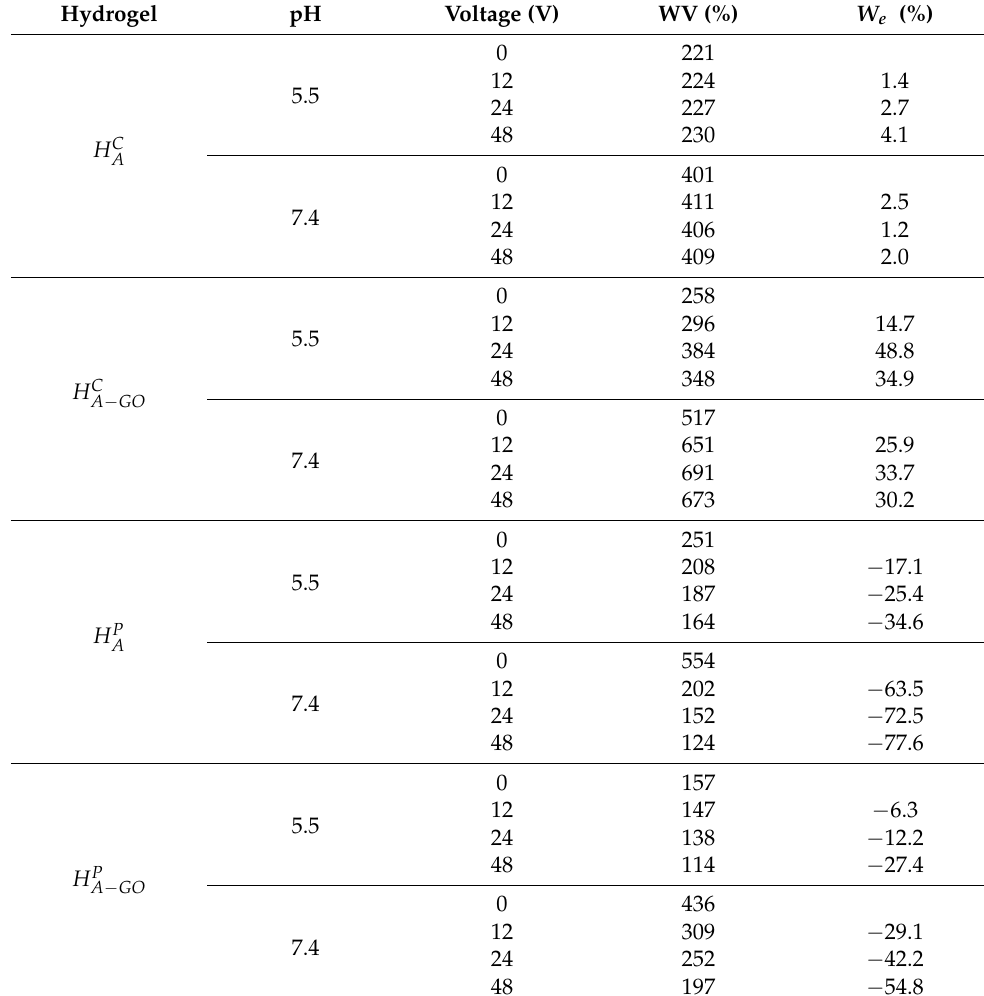
Table 1. Weight variation in water media of blank and hybrid hydrogels after 24 h incubation at pH 5.5 and 7.4 in the absence or presence of external